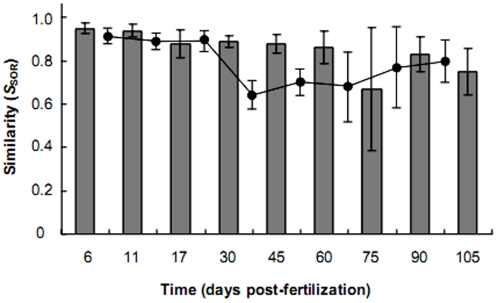
Changes in bacterial community similarity within and between time points.Bars indicate within time point similarity and circles represent similarity between adjacent time points. Similarity is measured by the Sørensen index of similarity (S
SOR). Error bars represent the standard deviation of the mean.